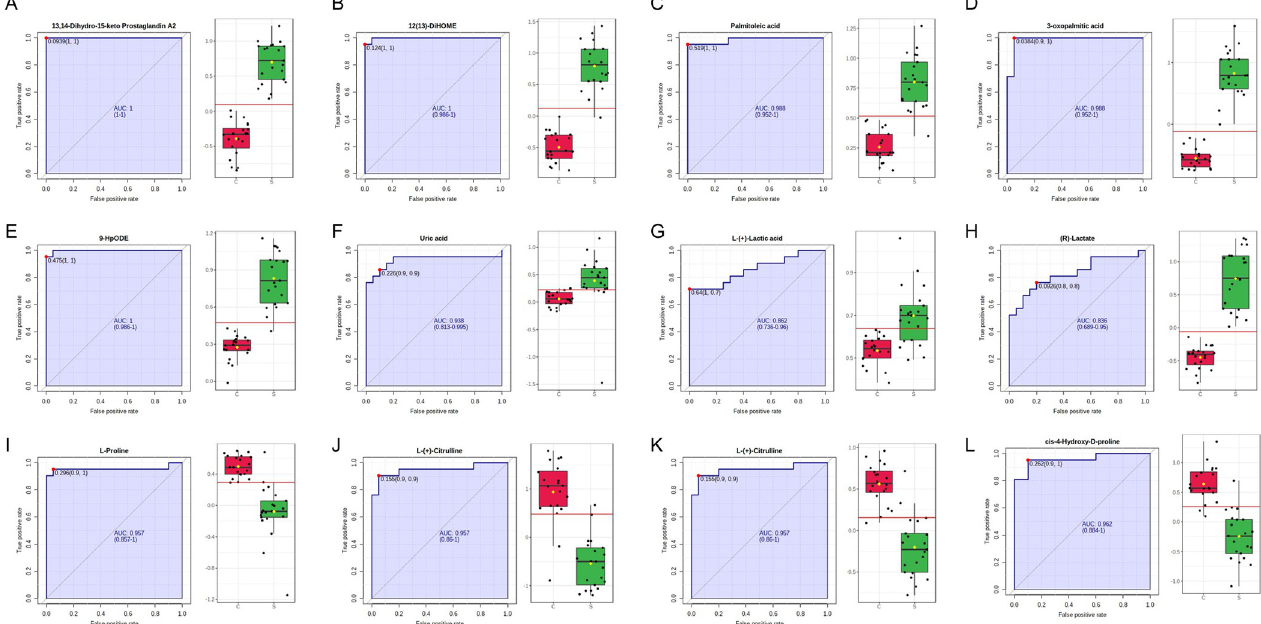
Fig 5. ROC plots of putative biomarkers for sepsis. (A-H) ROC plots of putative positive biomarkers for sepsis. (I-L) ROC plots of putative negative biomarkers for sepsis. Corresponding box-whisker plots for optimal cutoffs are displayed in tandem with each ROC curve.